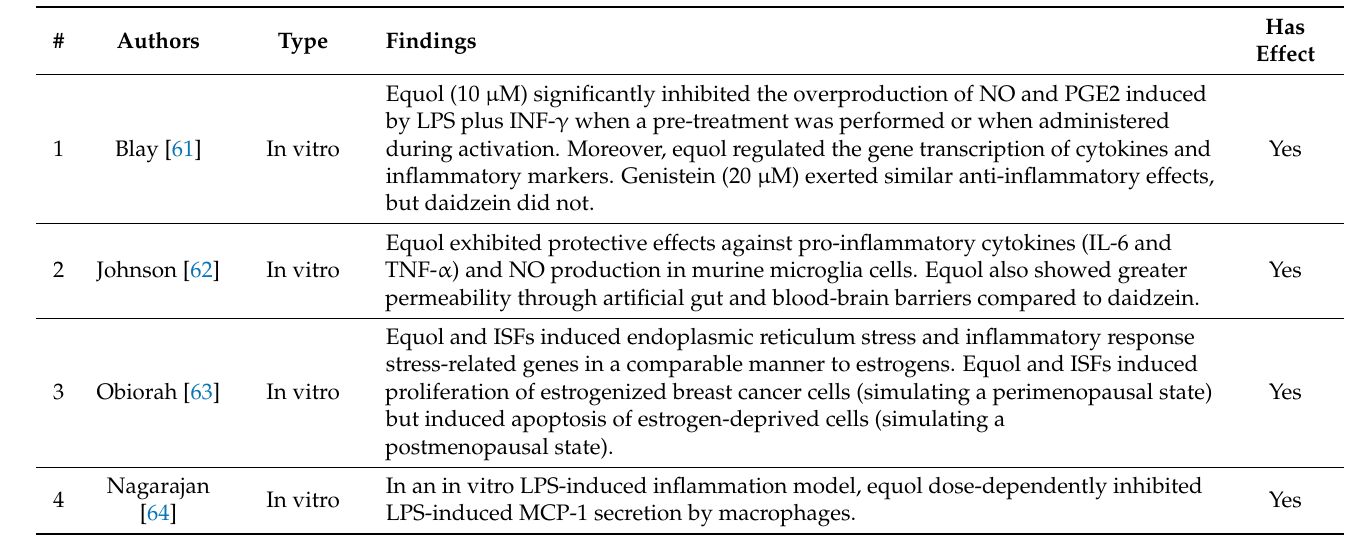
Table 1. Anti-inflammatory effects of